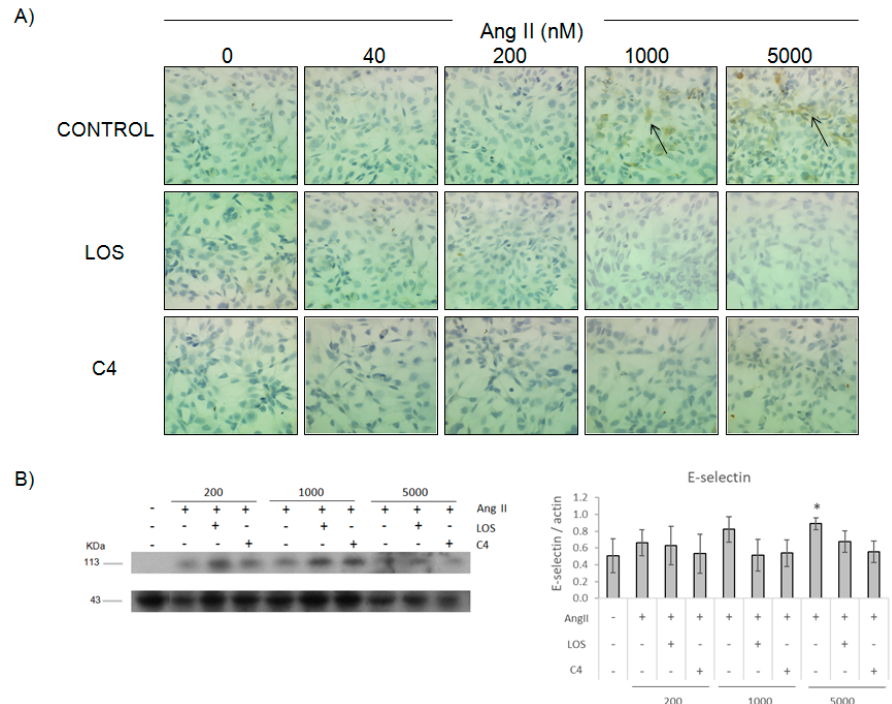
Figure 3. Effect of C4 on Ang II-induced E-selectin expression, 12 h after treatment. Immunocytochemistry ( A ). Western blot and expression relative to actin ( B ). Arrows indicate the E-selectin label. Microphotographs were taken with a 40× objective. LOS: Losartan; C4: Combination of SF1 and SF3, 10 µ g/mL each. Data are reported as mean ± SD and were analyzed by ANOVA and the post-hoc Tukey test. n = 4, * p < 0.05 vs. control (Ang II-free).